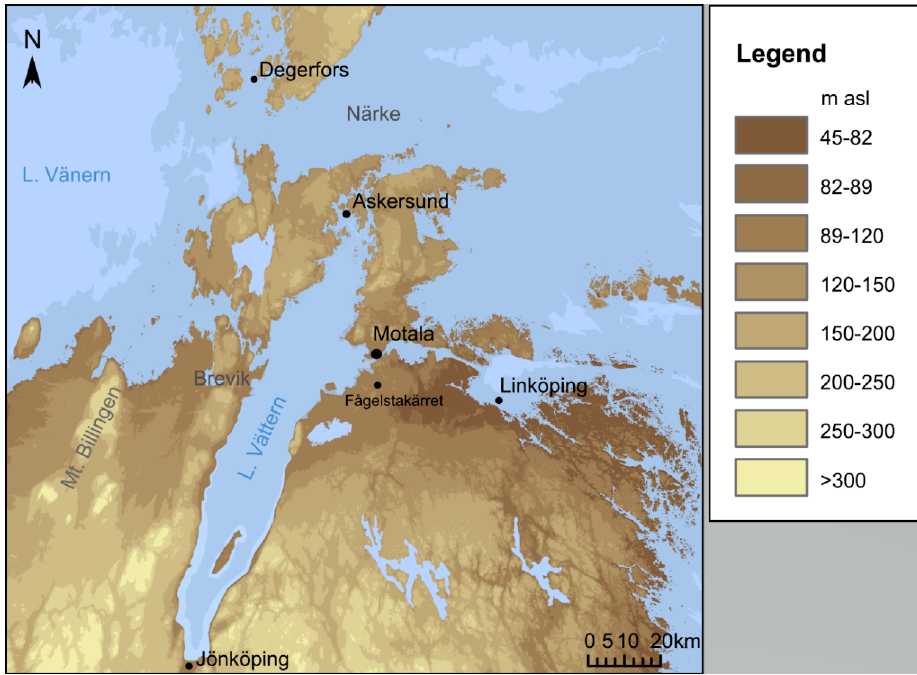
Figure 2. Map of central middle Sweden with the approximate extent of the Yoldia Sea at ca. 9000 cal BC (following online maps at www.sgu.se). The investigated area is located at the eastern shore of Lake Vättern in Motala. Notably: 150 m a.s.l. = the highest shoreline of the Baltic Ice Lake near Motala [5], 120 m a.s.l. = the highest shoreline of the Yoldia Sea near Motala [5]. The elevation of the